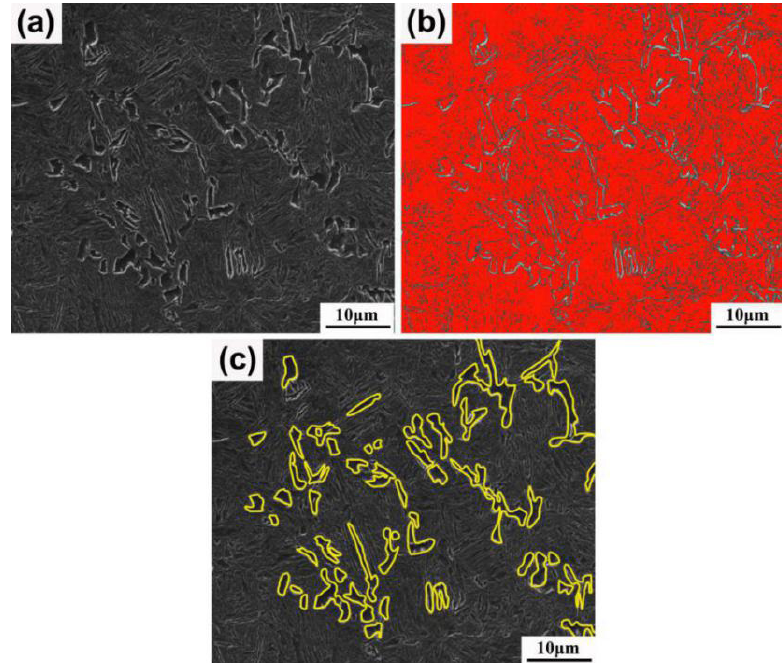
Figure 4. The example showing the method of calculating the volume fractions of ferrite and martensite: (a) the original micrograph; (b) the darker areas in Figure 4a are colored red; (c) the concave regions are manually